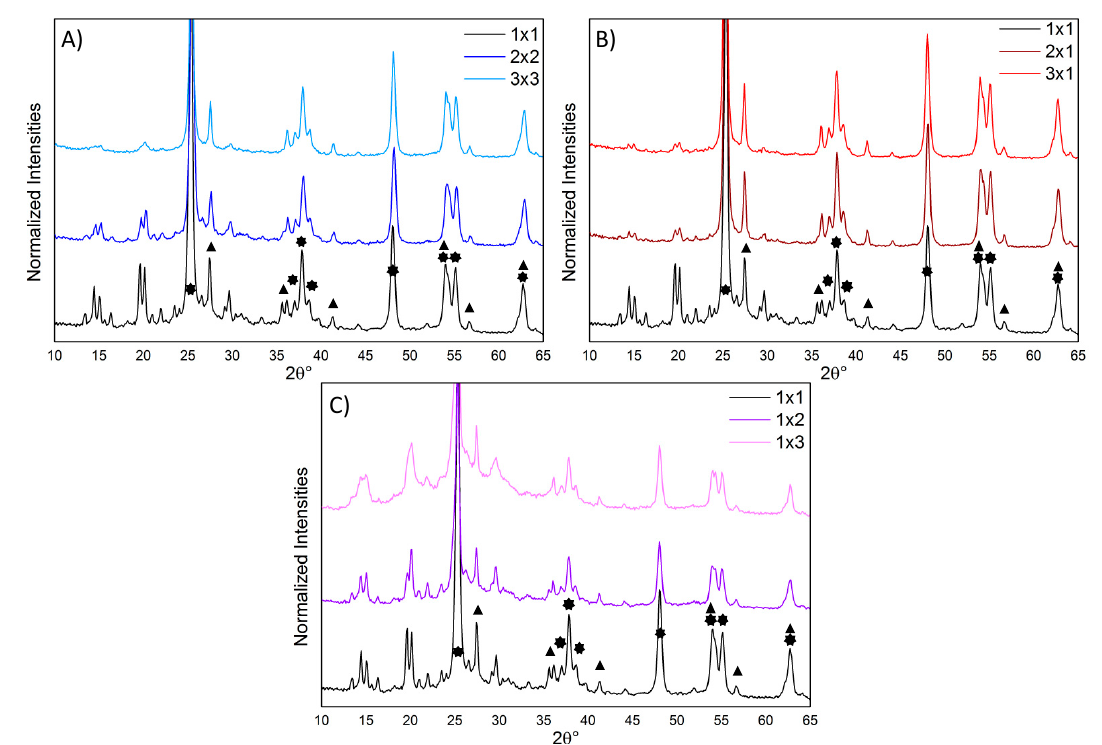
Figure 2. Normalized XRPD diffractograms (with respect to the anatase TiO 2 (213) peak): A ) effect of changing both the TiO 2 and H 2 O 2 amounts; B ) effect of changing only the TiO 2 amount; C ) effect of changing only the H 2 O 2 amount. The stars and triangles highlight the peaks related to the TiO 2 crystalline phases (anatase and rutile, respectively [41]).